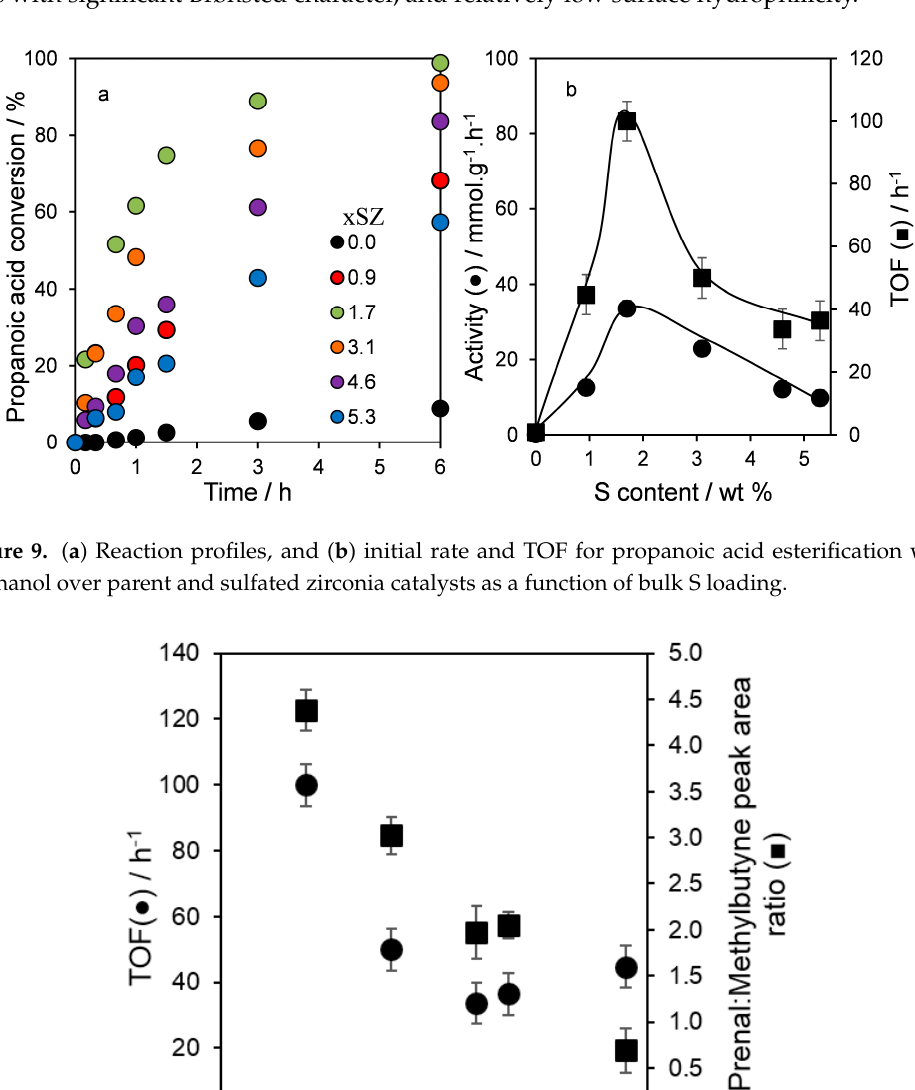
Figure 9. ( a ) Reaction profiles, and ( b ) initial rate and TOF for propanoic acid esterification with methanol over parent and sulfated zirconia catalysts as a function of bulk S loading.